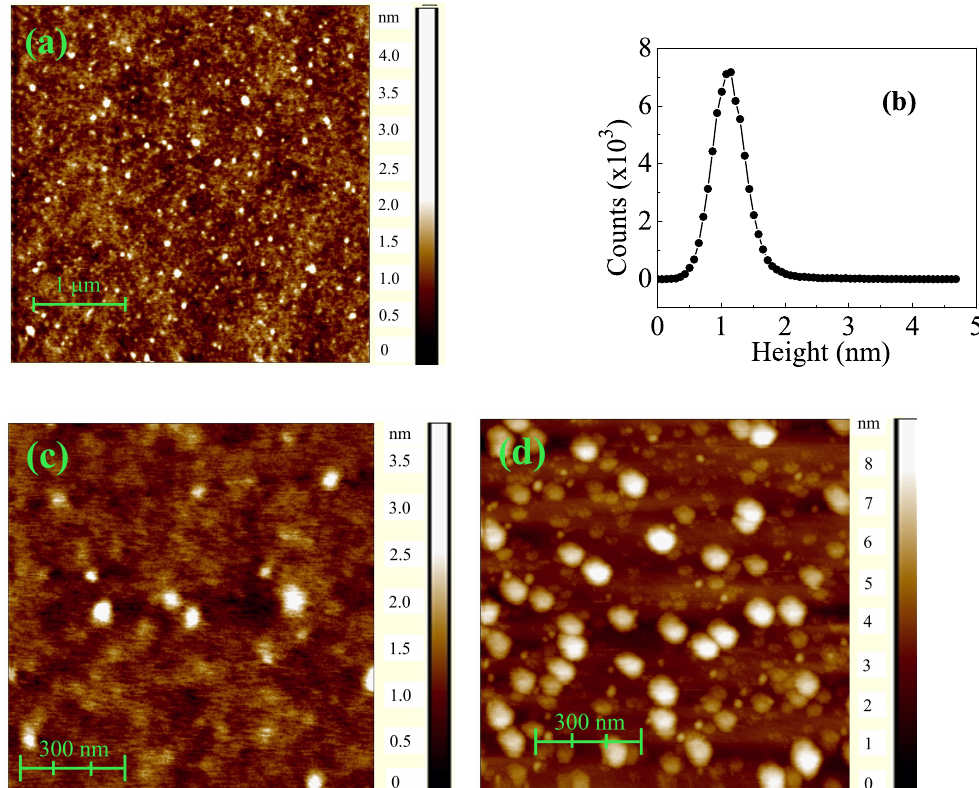
Figure 3. Panel of figures concerning AFM topographic characterization of our Co-cluster assemblies: ( a , b ) surface image and height distribution at t ∼ 2 nm, ( c , d ) reduced AFM scans at t ∼ 2 and 5 nm,